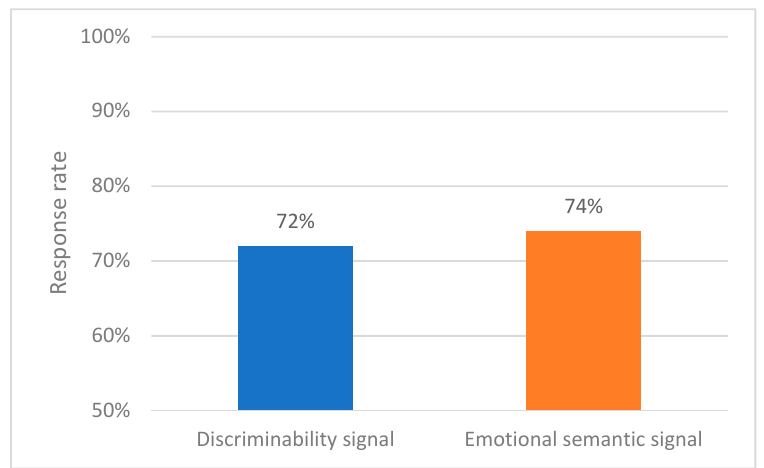
Figure 8. Response rate (discriminability vs. emotional semantics). Table 8. Chi-square analysis results for response rate.